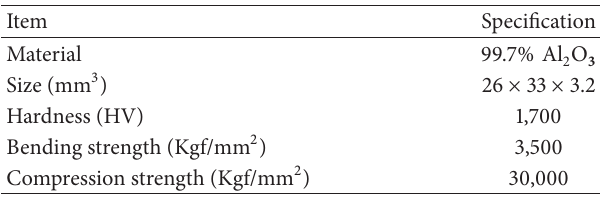
Table 4: Experimental results for cracking percentage.